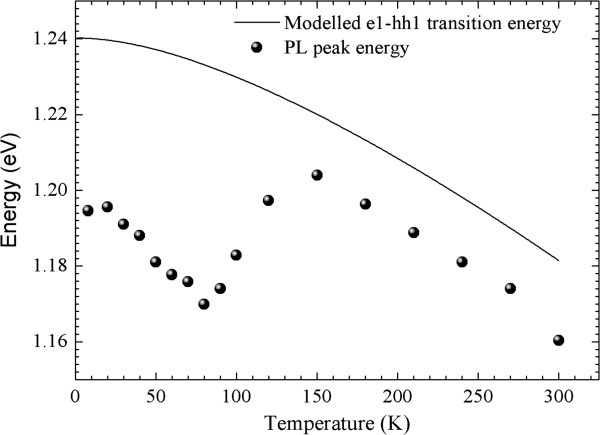
The s-shape PL shift of the investigated sample.